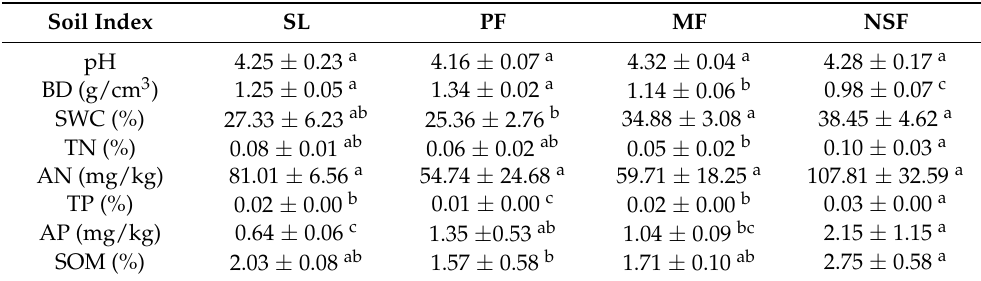
Table 2. Soil basic properties under four restoration community